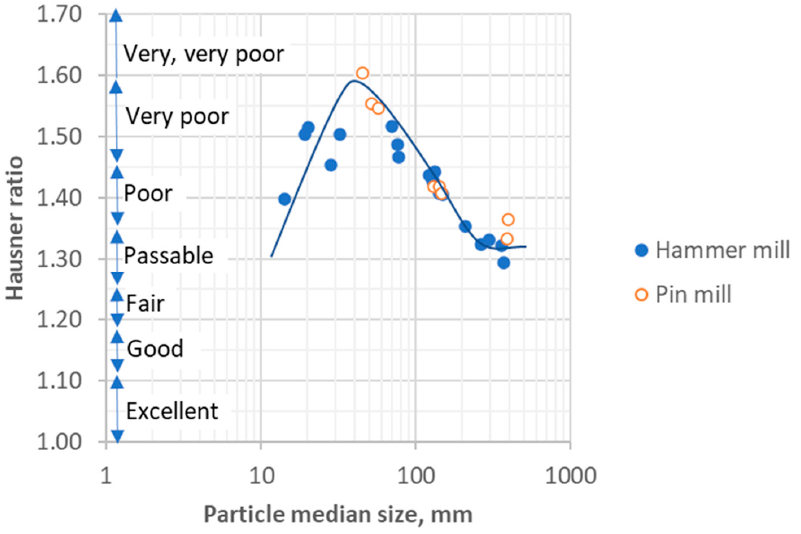
Figure 10. Hausner ratio as a function of median size. Flow characterization according to Fitzpatrick [3].